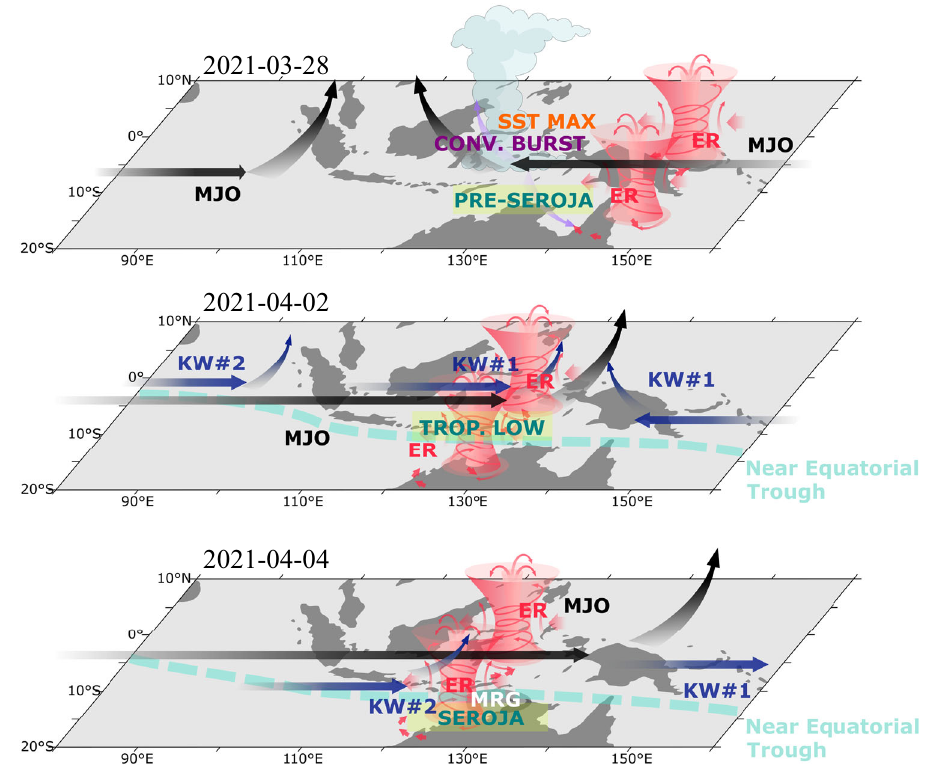
Fig. 9 | A conceptual diagram of meteorological drivers of TC Seroja. Abbre- viations are as follows: SST MAX — maximum of the Sea Surface Temperatures; CONV. BURST — Convective Burst; KW — Convectively Coupled Kelvin Wave; ER —